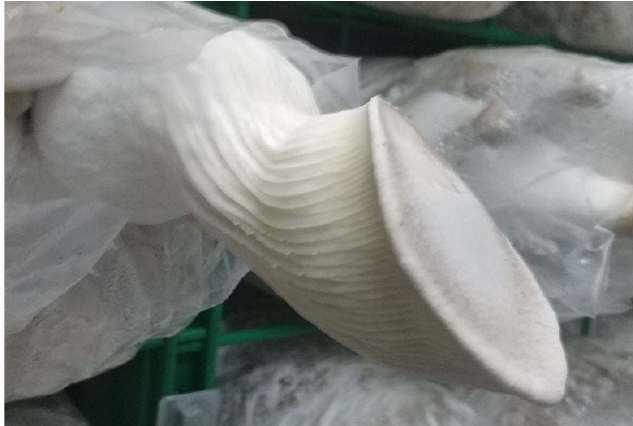
Figure 5. Fruiting body of P. eryngii under blue light irradiation